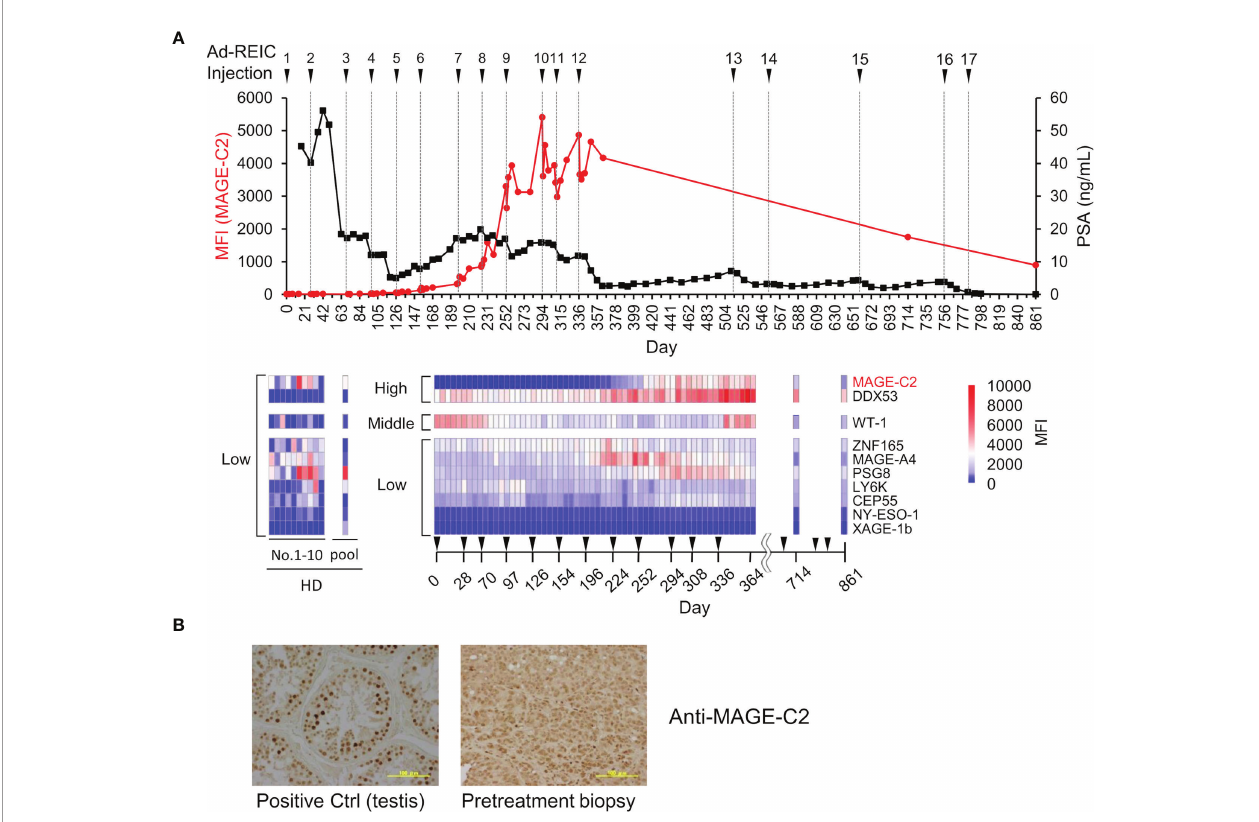
FIGURE 6 | Demonstration of immune monitoring by MUSCAT assay panel on a single, patient-derived clinical sample. (A) The line graph represents anti-MAGE-C2 antibodies and PSA changes. The heat map shows changes in the levels of 10 different serum autoantibodies. The dilution ratio of serum autoantibodies was adjusted to 80,000-fold dilution for high titer, 16,000-fold dilution for middle antibody titer, and 1,600-fold for low titer samples. Autoantibody levels in ten healthy donor individuals and a pooled sample. (B) Detection of MAGE-C2 protein in the tumor tissues. Scale bar represents 100